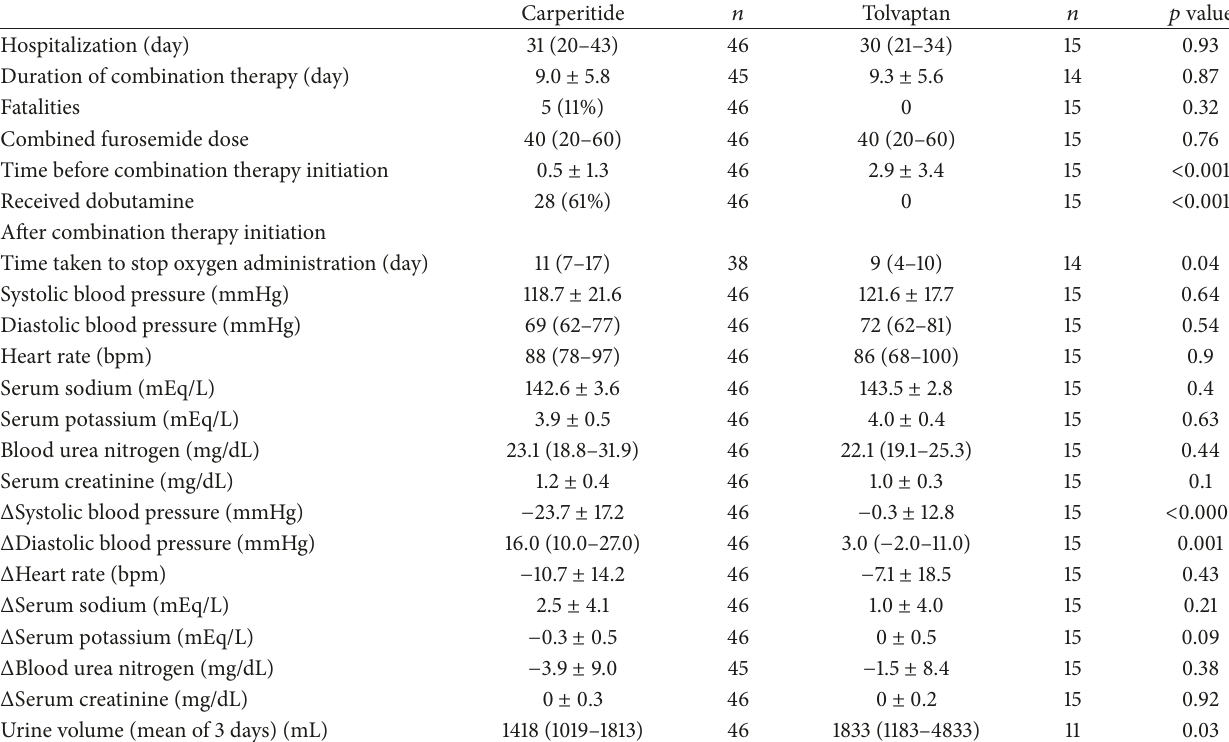
Table 2: After the initiation of carperitide or tolvaptan therapy. The values are expressed in mean (standard deviation) and median (interquartile